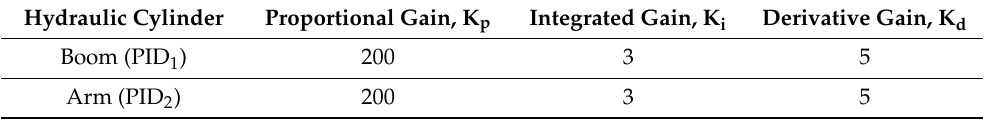
Figure 9. Control system diagram, where PID 1 is the PID controller of boom section and PID 2 is the PID controller of arm section. Table 3. Parameters of the PID controllers.